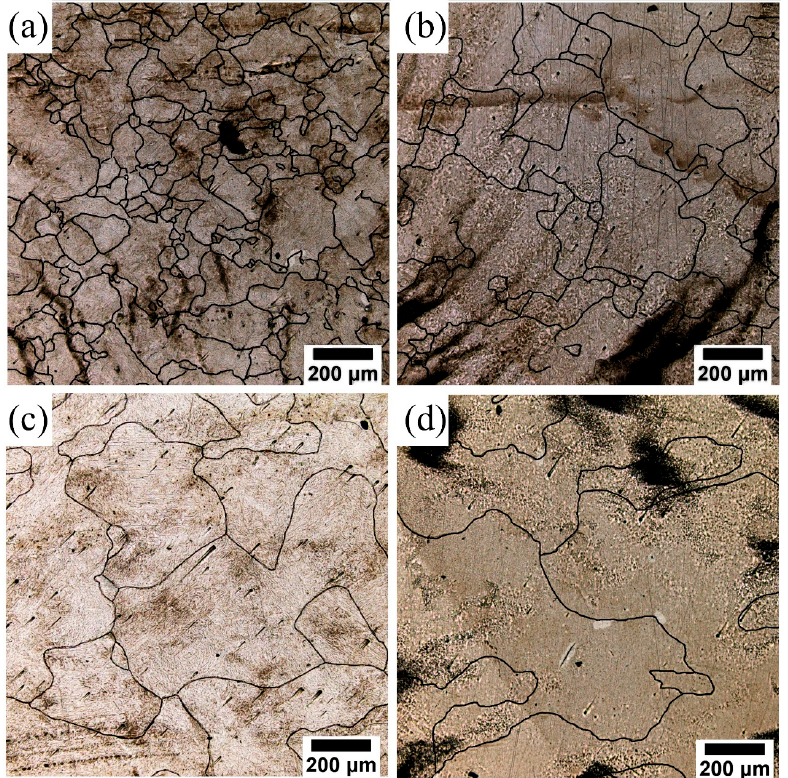
Figure 10. Austenite grain under strain rate 0.01 s − 1 of ( a ) 1200 °C; ( b ) 1250 °C; ( c ) 1300 °C; and ( d ) 1350 °C. and ( d ) 1350 ◦